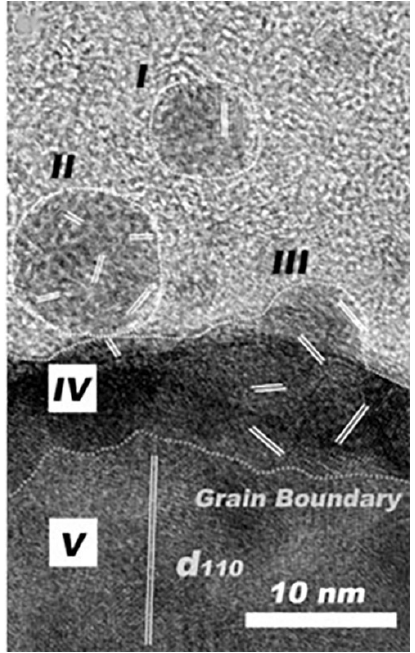
Figure 10. The process of random attachment of nanocrystals to the surface of vaterite. (I) Individ- ual nanoparticle; (II) initial attachment of a nanocrystal without lattice matching; (III) later stage of attachment of a nanocrystal with the spindle vaterite surface without lattice matching; (IV) nonoriented surface layer; (V) oriented bulk. The figure is reproduced with copyright permission of ref. [80].